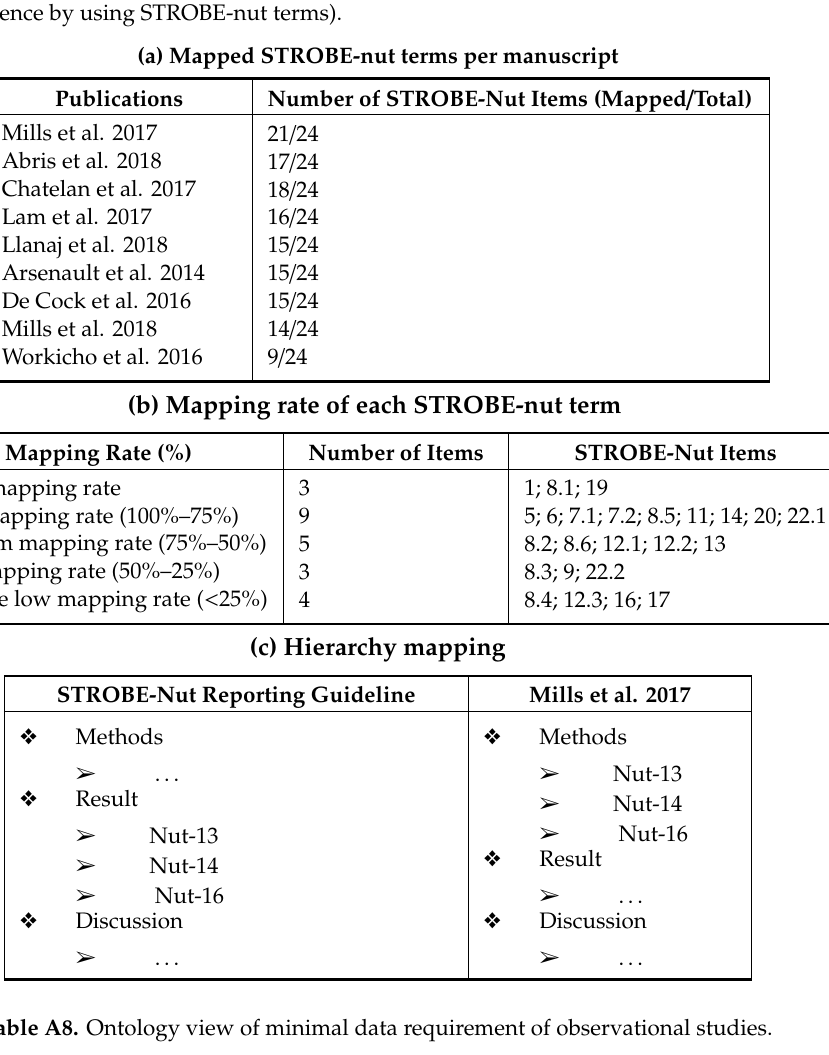
Table A7. Case study: estimation of reporting completeness in a sample of nine manuscripts (reporting quality reference by using STROBE-nut terms).